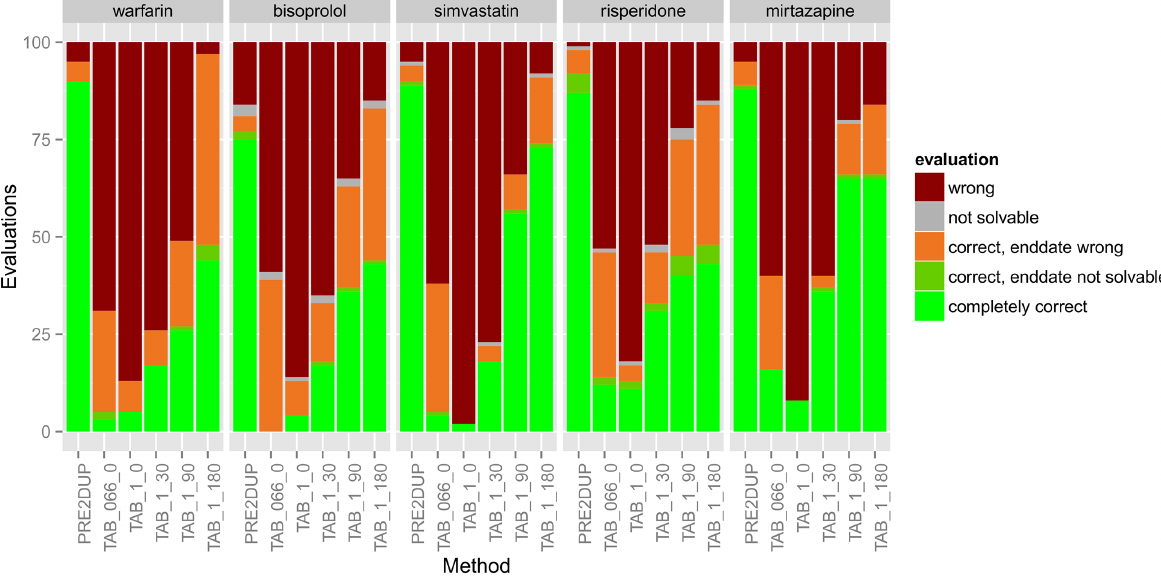
PLOS ONE | https://doi.org/10.1371/journal.pone.0184070 September 8,